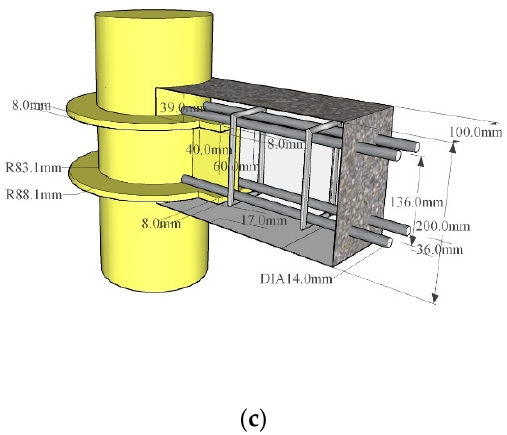
Figure 2. Details of the construction of the beam–column connection in ( a ) plane view, ( b ) elevation view and ( c ) spatial view.